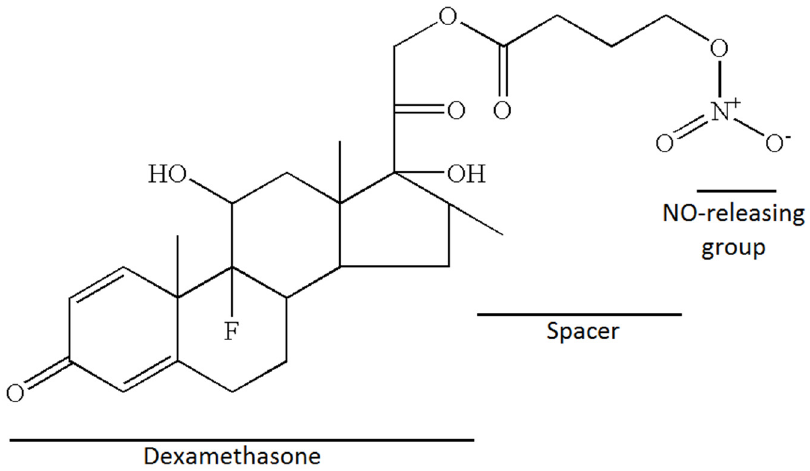
Figure 1. Chemical structure of NCX-1005: dexamethasone 21-(4-nitrooxybutyrate).